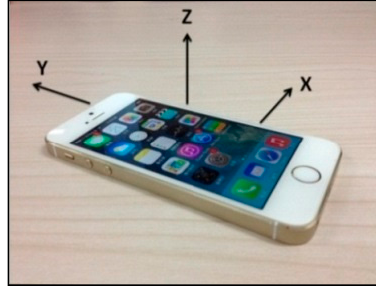
Figure 3. Acceleration directions.